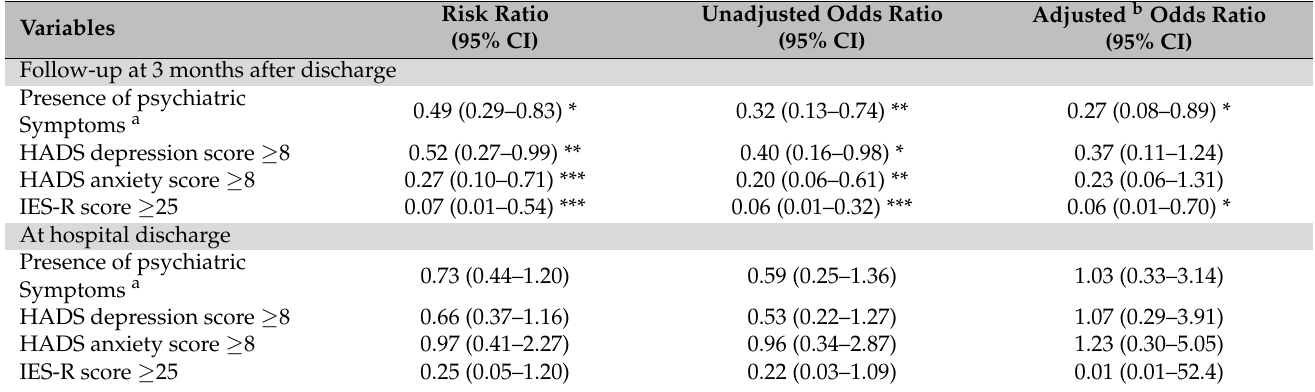
Table 3. Association between early mobilization and the presence of psychiatric